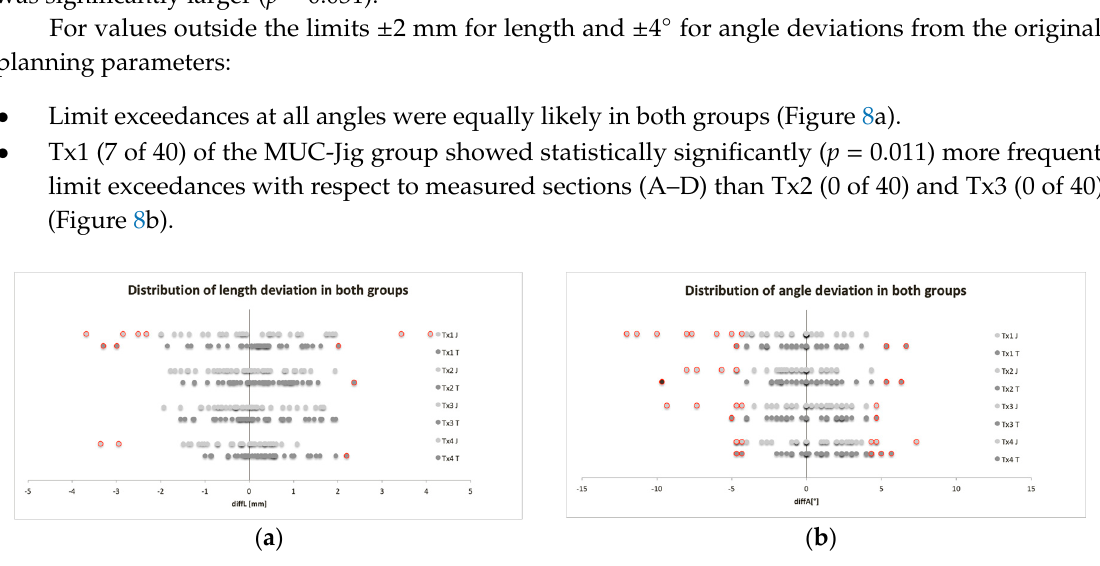
Figure 8. Distributions of all relative length ( a ) and angle ( b ) deviations from the original planning parameters assessed for each transplant (Tx1–Tx4) and both methods (J: MUC-Jig, T: template). Values outside the limits ( ± 2 mm, ± 4 ◦ ) are shown in